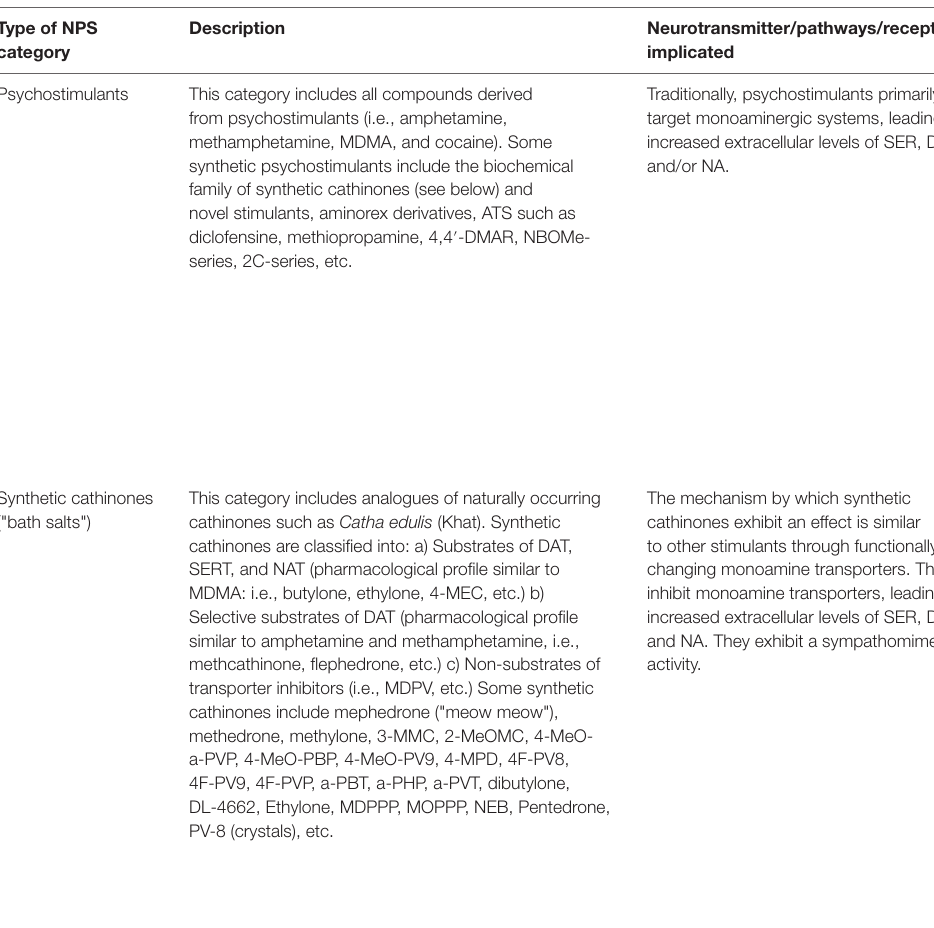
TABLe 1 | Pharmacological and clinical features of the main NPS